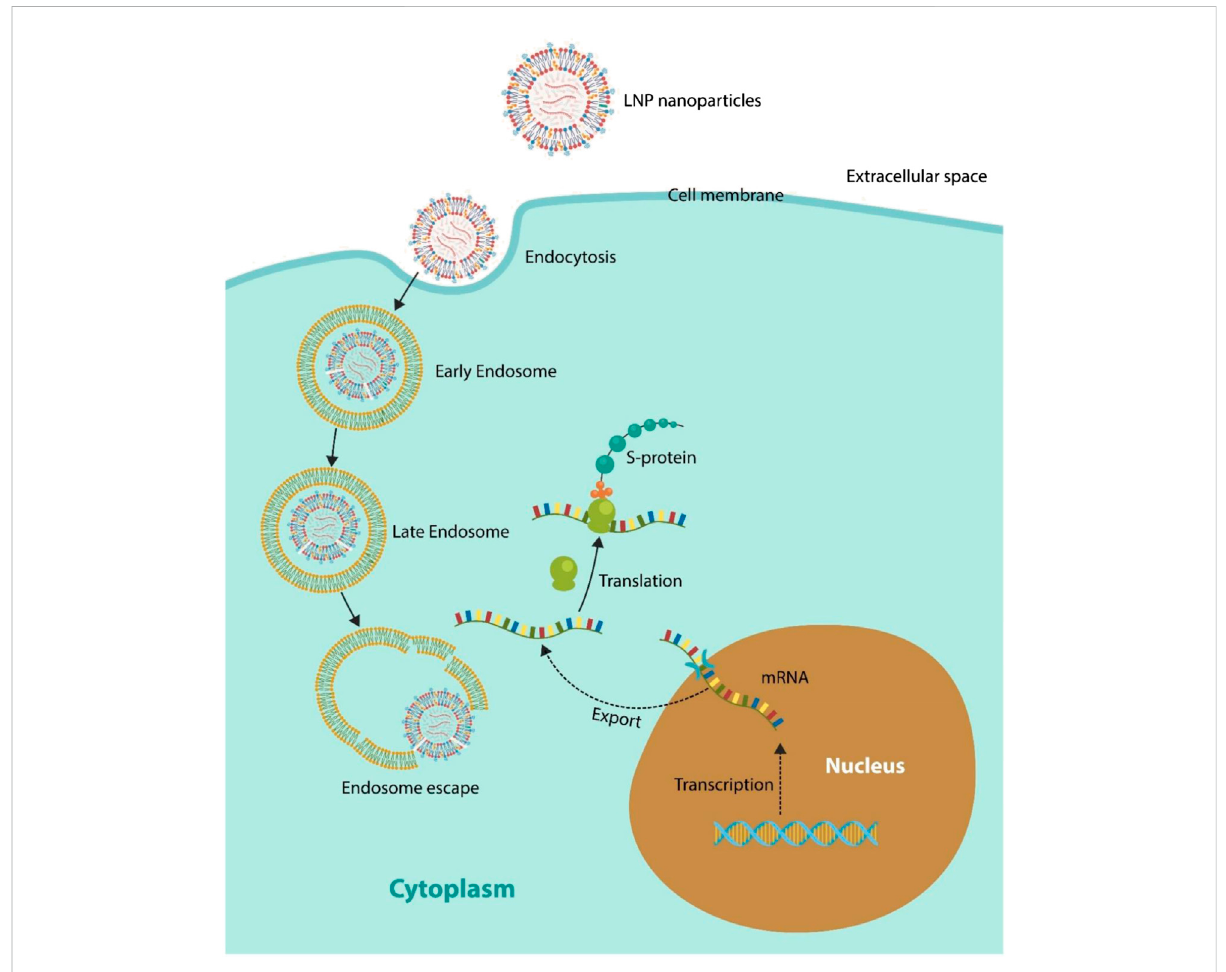
FIGURE 1 LNPs enter host cells via endocytosis or phagocytosis (immune cell endocytosis). LNP is traf fi cked through the ELS, traveling from early to late endosomes. Progressing from late endosome to lysosomes would risk LNP degradation by the hydrolyzing enzymes; therefore, ELS escape must take place in late endosome. However, late endosomes may expulse their cargo into the extracellular compartment via EVs (not shown). This is a major hurdle that LNPs must negotiate. Under ideal circumstances, ribosomes translate the exogenous mRNA into the S protein. For this to occur, it must be assumed that the human translation machinery does not differentiate between endogenous (nucleus-derived) and exogenous